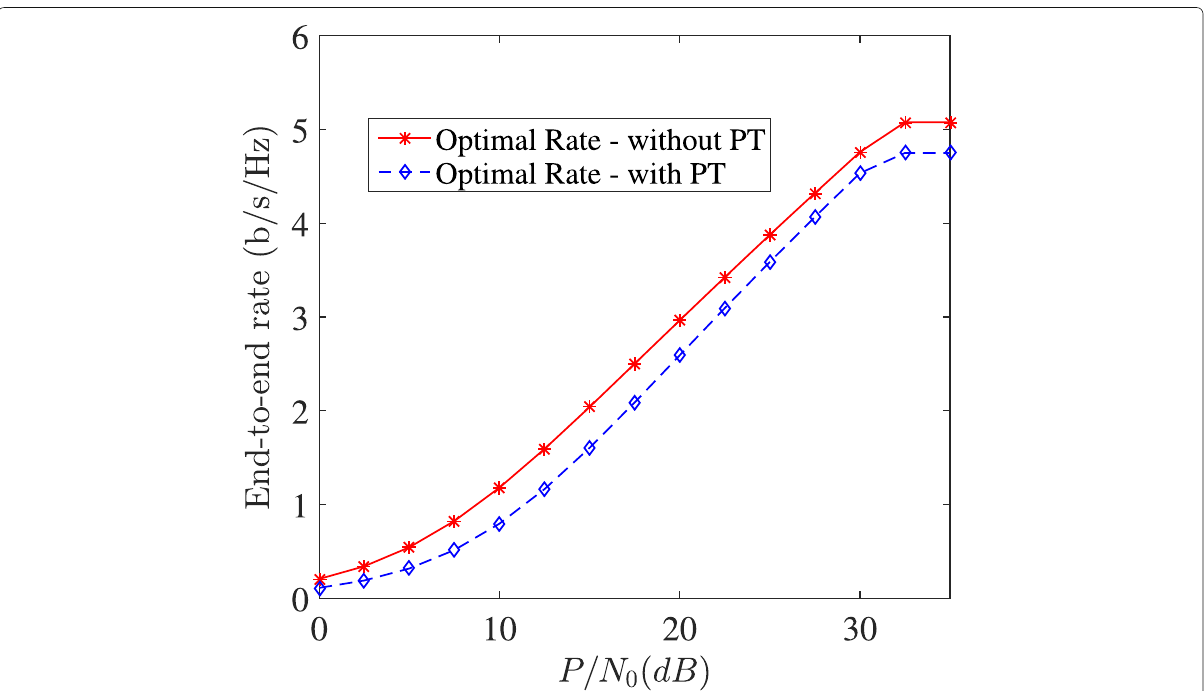
Fig. 15 End-to-end instantaneous rate comparison with and without interference from PT; P PT / N 0 = 10